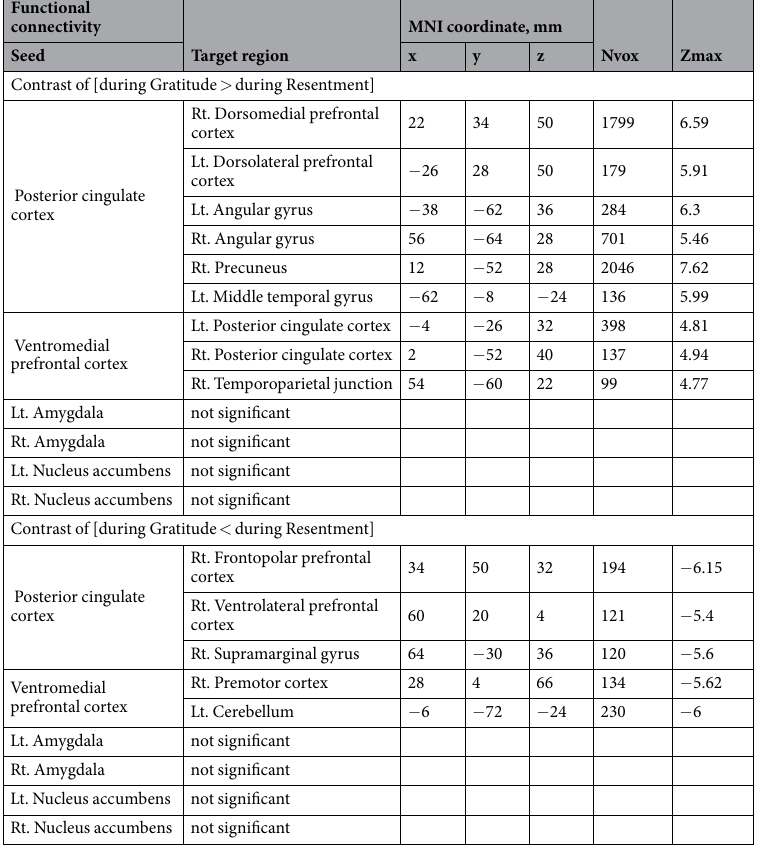
Inter-network rsFC such as the temporolimbic–left frontoparietal, temporolimbic–right frontoparietal, and exec- utive–left frontoparietal networks were significantly increased after the resentment intervention compared to the baseline (Bonferroni-corrected P < 0.05).